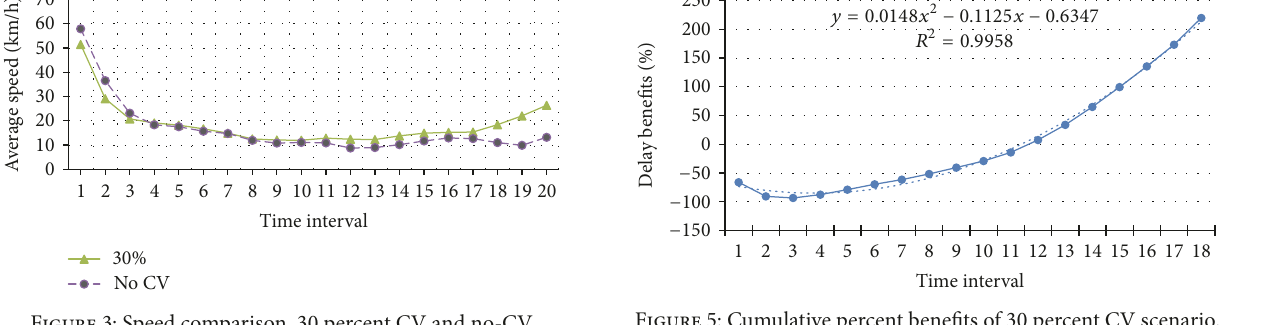
Figure 3: Speed comparison, 30 percent CV and no-CV.